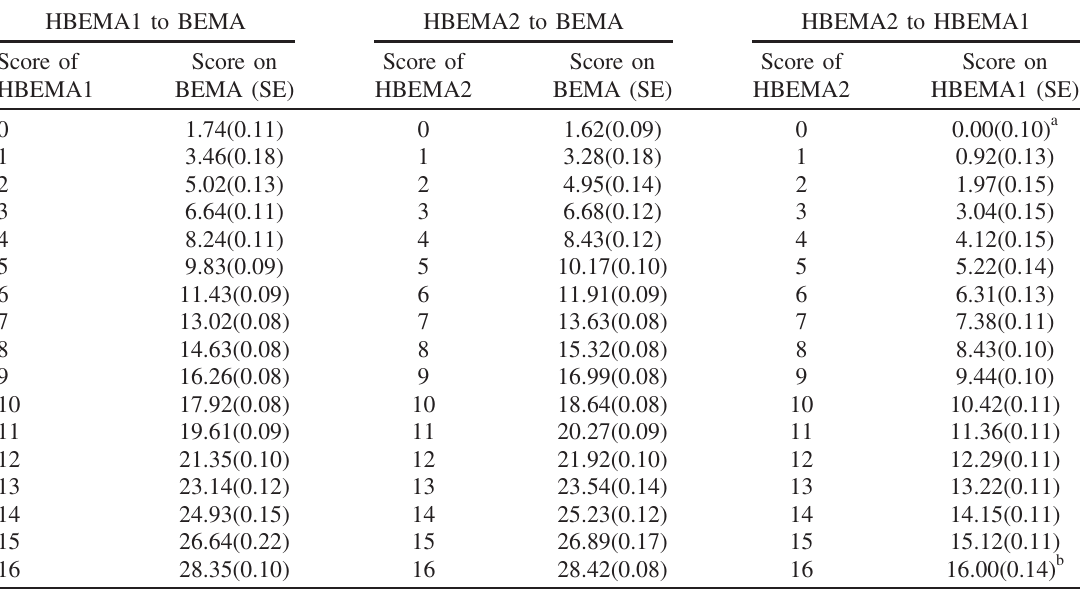
plotted in Figs. 2(b), 2(d), 2(f) and summarized in Table III.